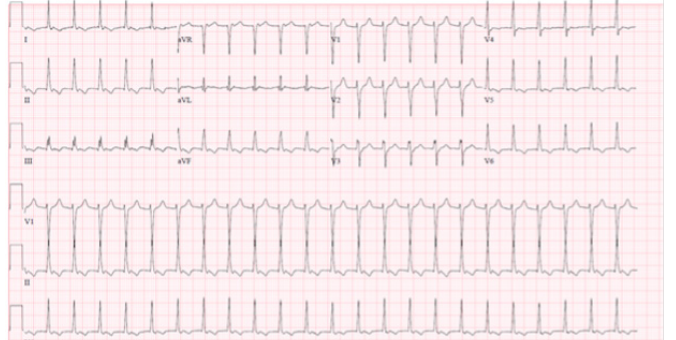
Image 2. Initial electrocardiogram of a 55-year-old male on hemodialysis who presented to the emergency department with